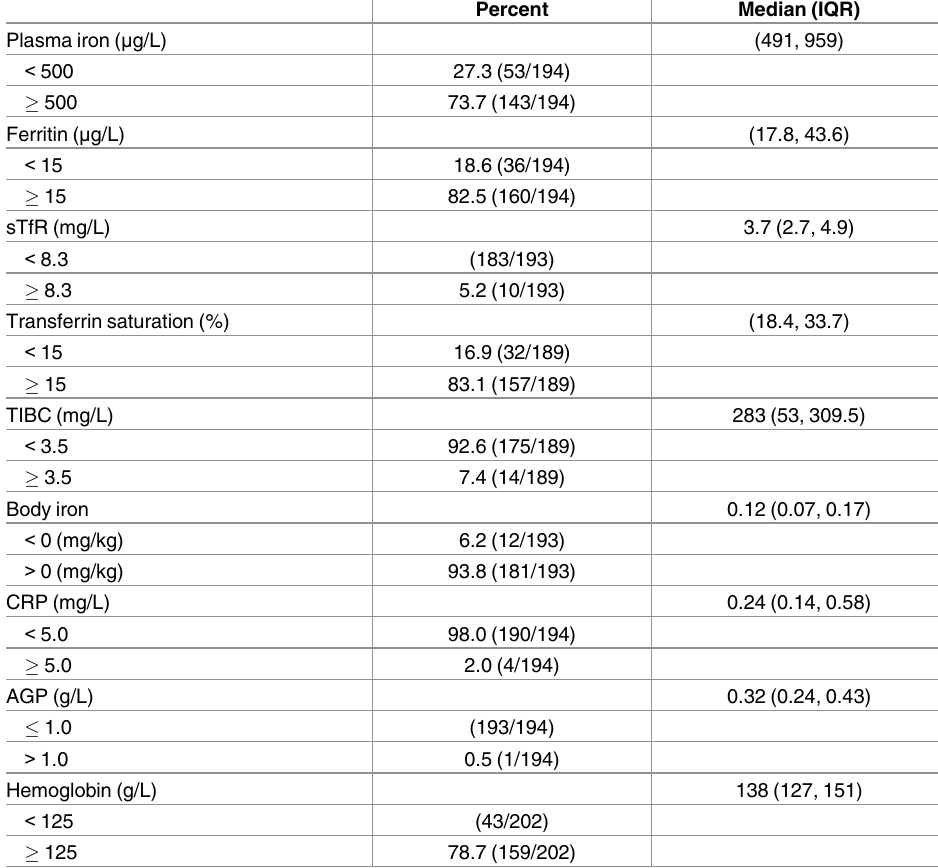
Table 4. Iron status biomarkers and inflammation indicators (CRP and AGP) of rural women from Sidama zone, southern Ethiopia (n =